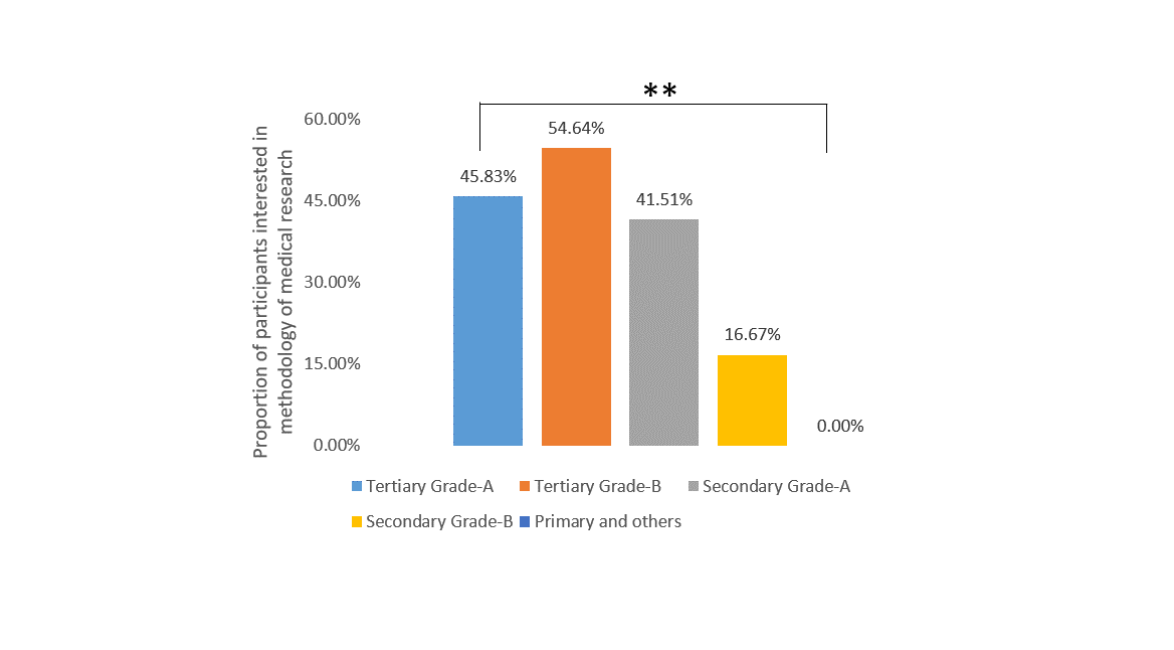
Figure 4. Proportions of participants interested in learning about the methodology of medical research at urology conferences stratified by hospital level. ** P ＜